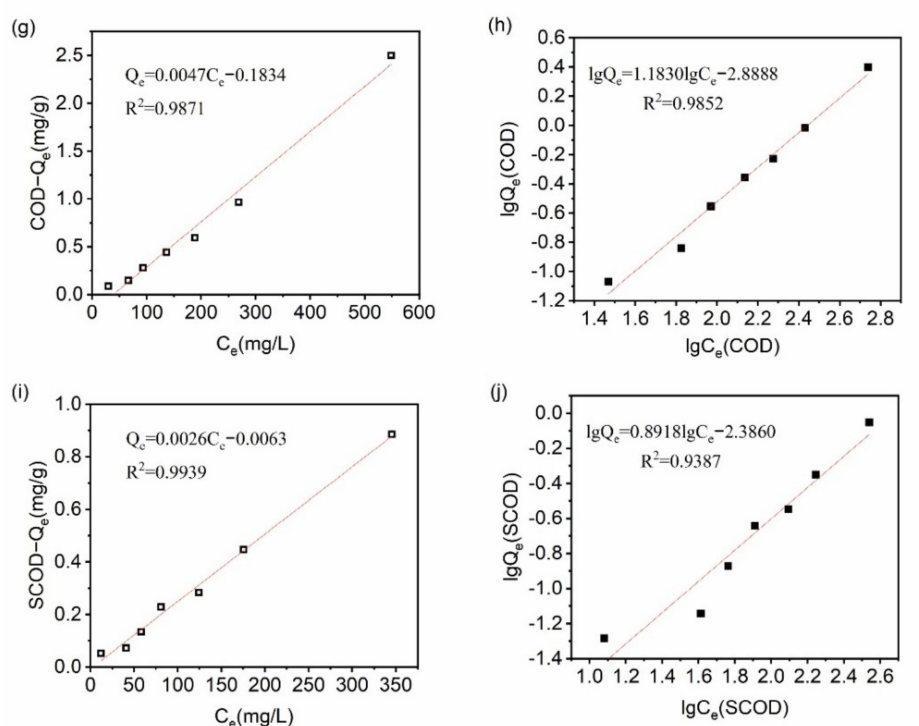
Figure 5. Isothermal adsorption curves of soil to reclaimed fertilizer. ( a ) TAN fitted with linear model; ( b ) TAN fitted with Freundlich model; ( c ) TN fitted with linear model; ( d ) TN fitted with Freundlich model; ( e ) TP fitted with linear model; ( f ) TP fitted with Freundlich model; ( g ) COD fitted with linear model; ( h ) COD fitted with Freundlich model; ( i ) SCOD fitted with linear